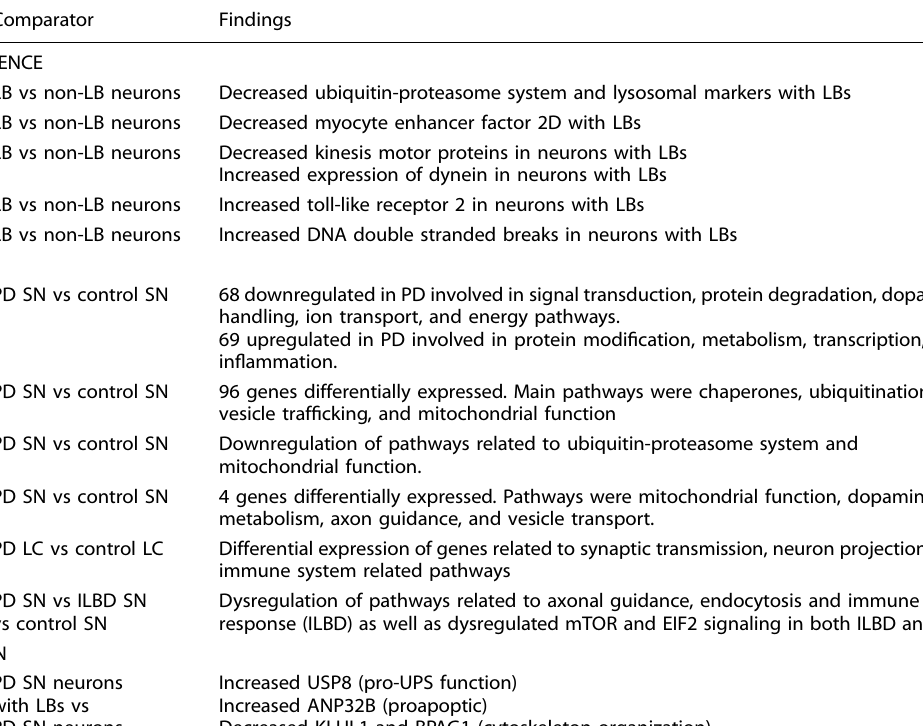
Table 1. Synucleinopathy-associated pathogenesis in postmortem PD